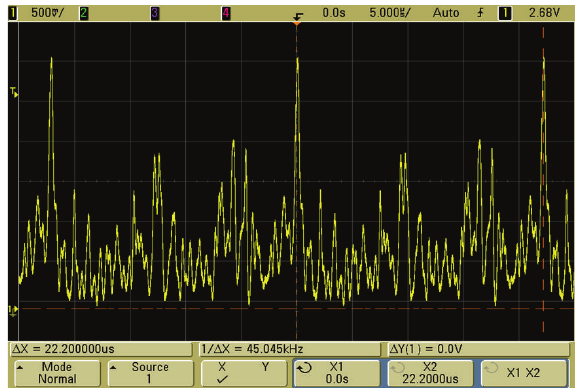
Figure 7: For the 5 𝜇 s frequency for exponential